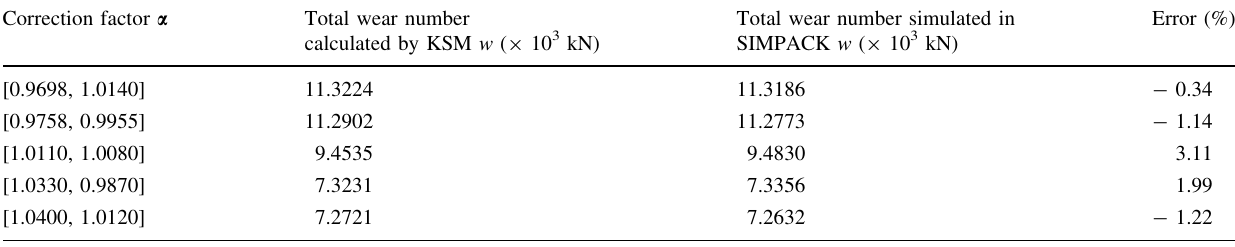
(2) From Fig. 12d, it can be seen that changing a 1 significantly affects the wear number, but changing a 2 has a relatively small effect on the wear number, which means that the value of a 2 can be selected within the range of 0 : 98 (cid:6) a 2 (cid:6) 1 : 02. From the